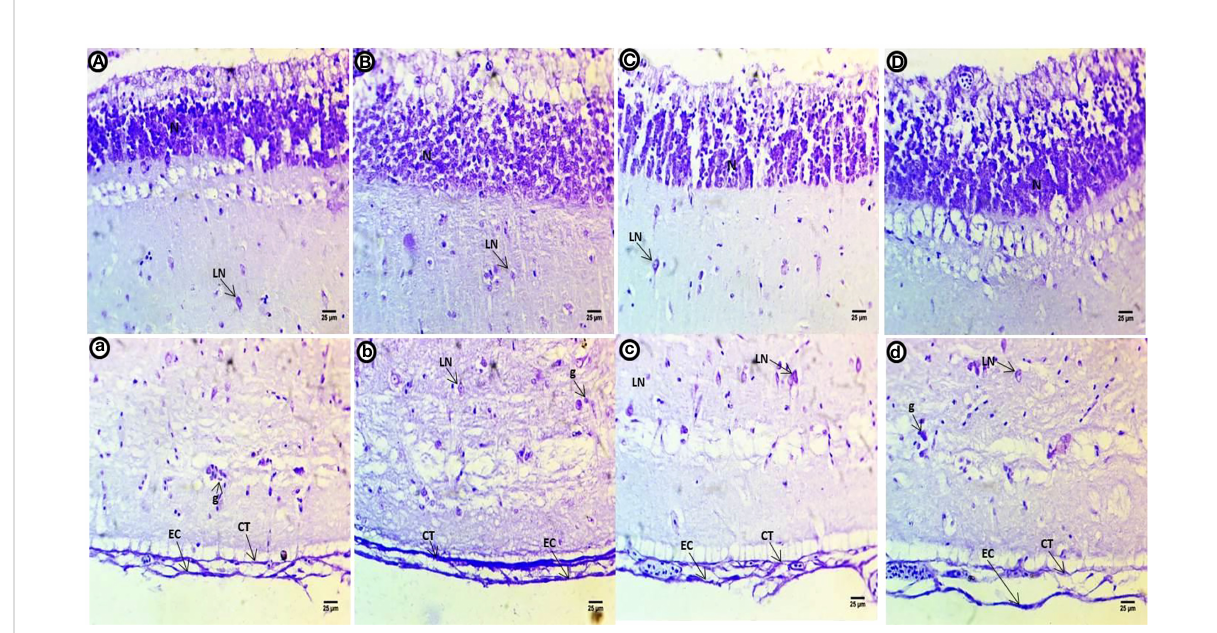
FIGURE 4 Crystal violet-stained sections of the optic tectum of common carp showing the control group (A, a) , after a two-week exposure to 10 mg/L PE-MPs (B, b) , 10 mg/L PE-MPs +200 µg/L 4-NP (C, c) , and 200 µg/L4-NP (D, d) . Glial cells (g), large neurons (LN), connective tissue (CT), epithelial cells